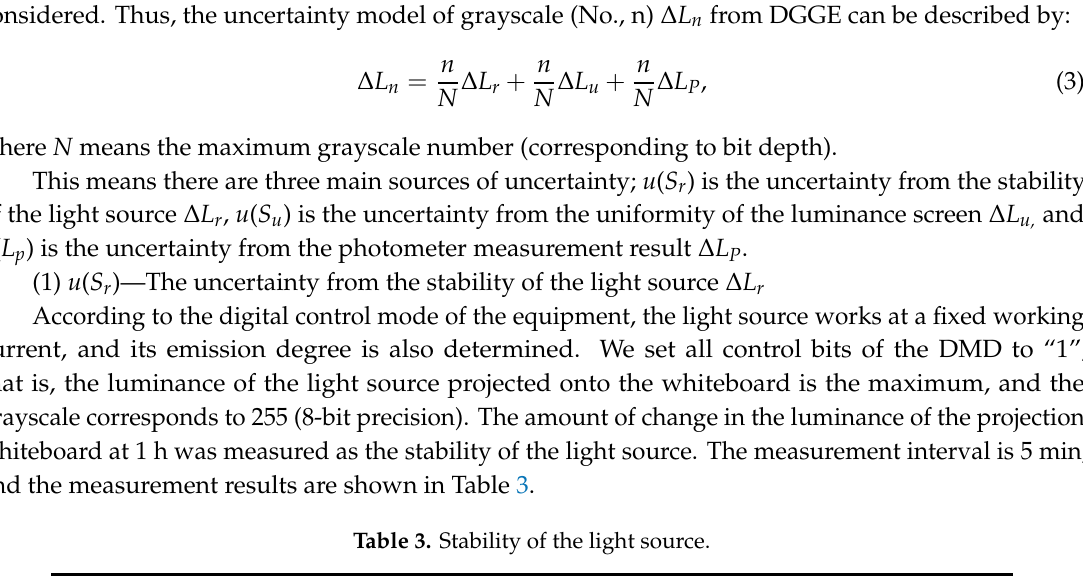
Table 3. Stability of the light source